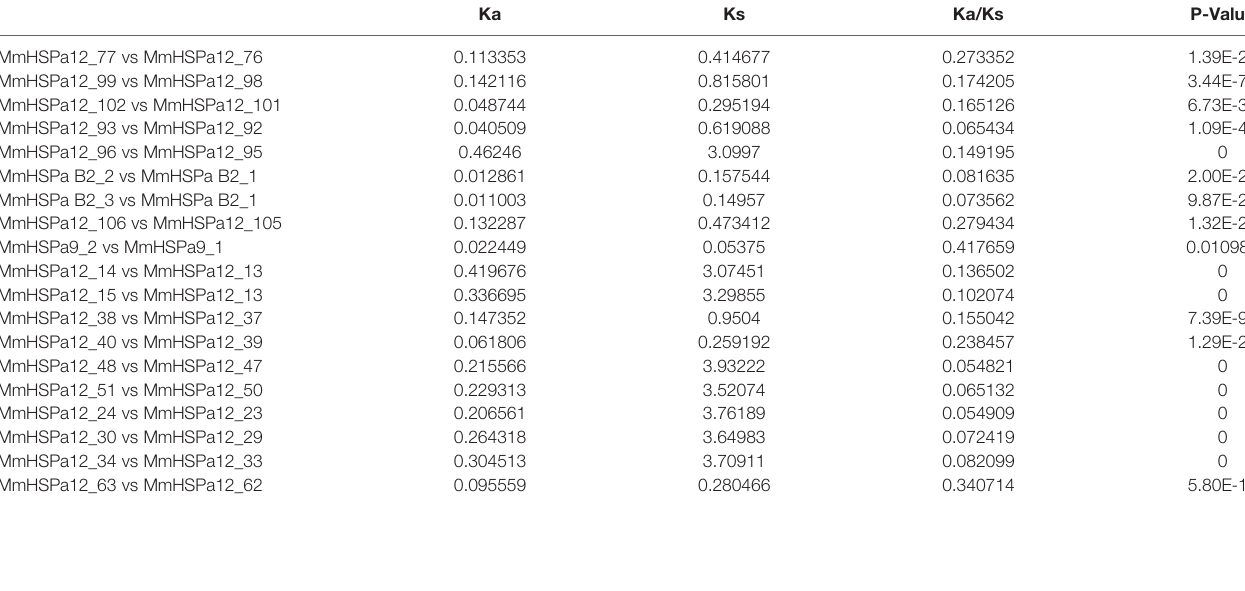
TABLE 1 | Selection pressure on the tandem duplication HSP70 gene pairs.